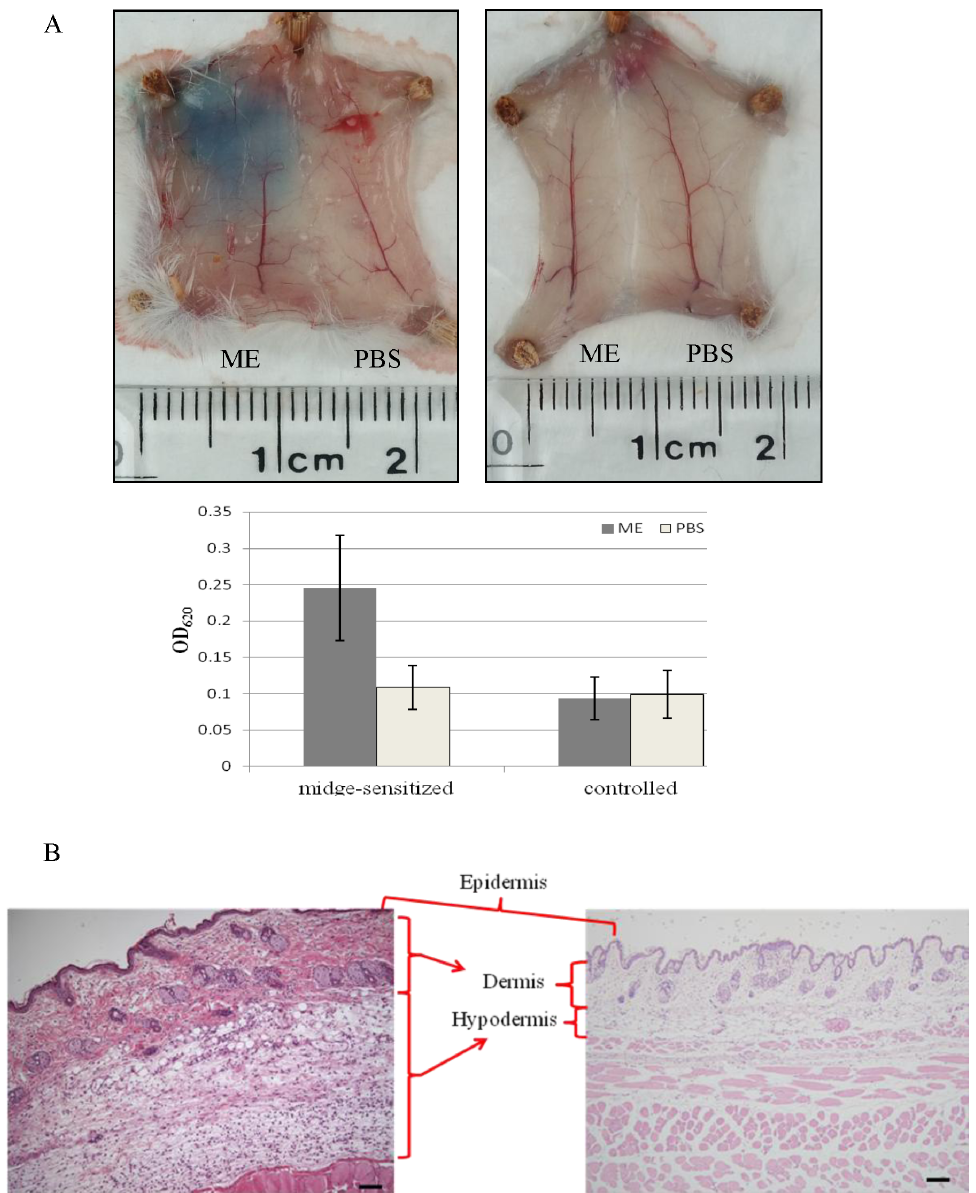
Figure 5. Representative skin biopsies of midge-sensitized or controlled mice. (A) Evans blue injection or (B) H and E-staining of abdominal skin sections from a midge-sensitized mouse (A, left and B) and a controlled mouse (A, right) after intra-dermal injection with PBS and midge extract (ME) at the indicated sides for 20 minutes. Magnification in B was 6 100.